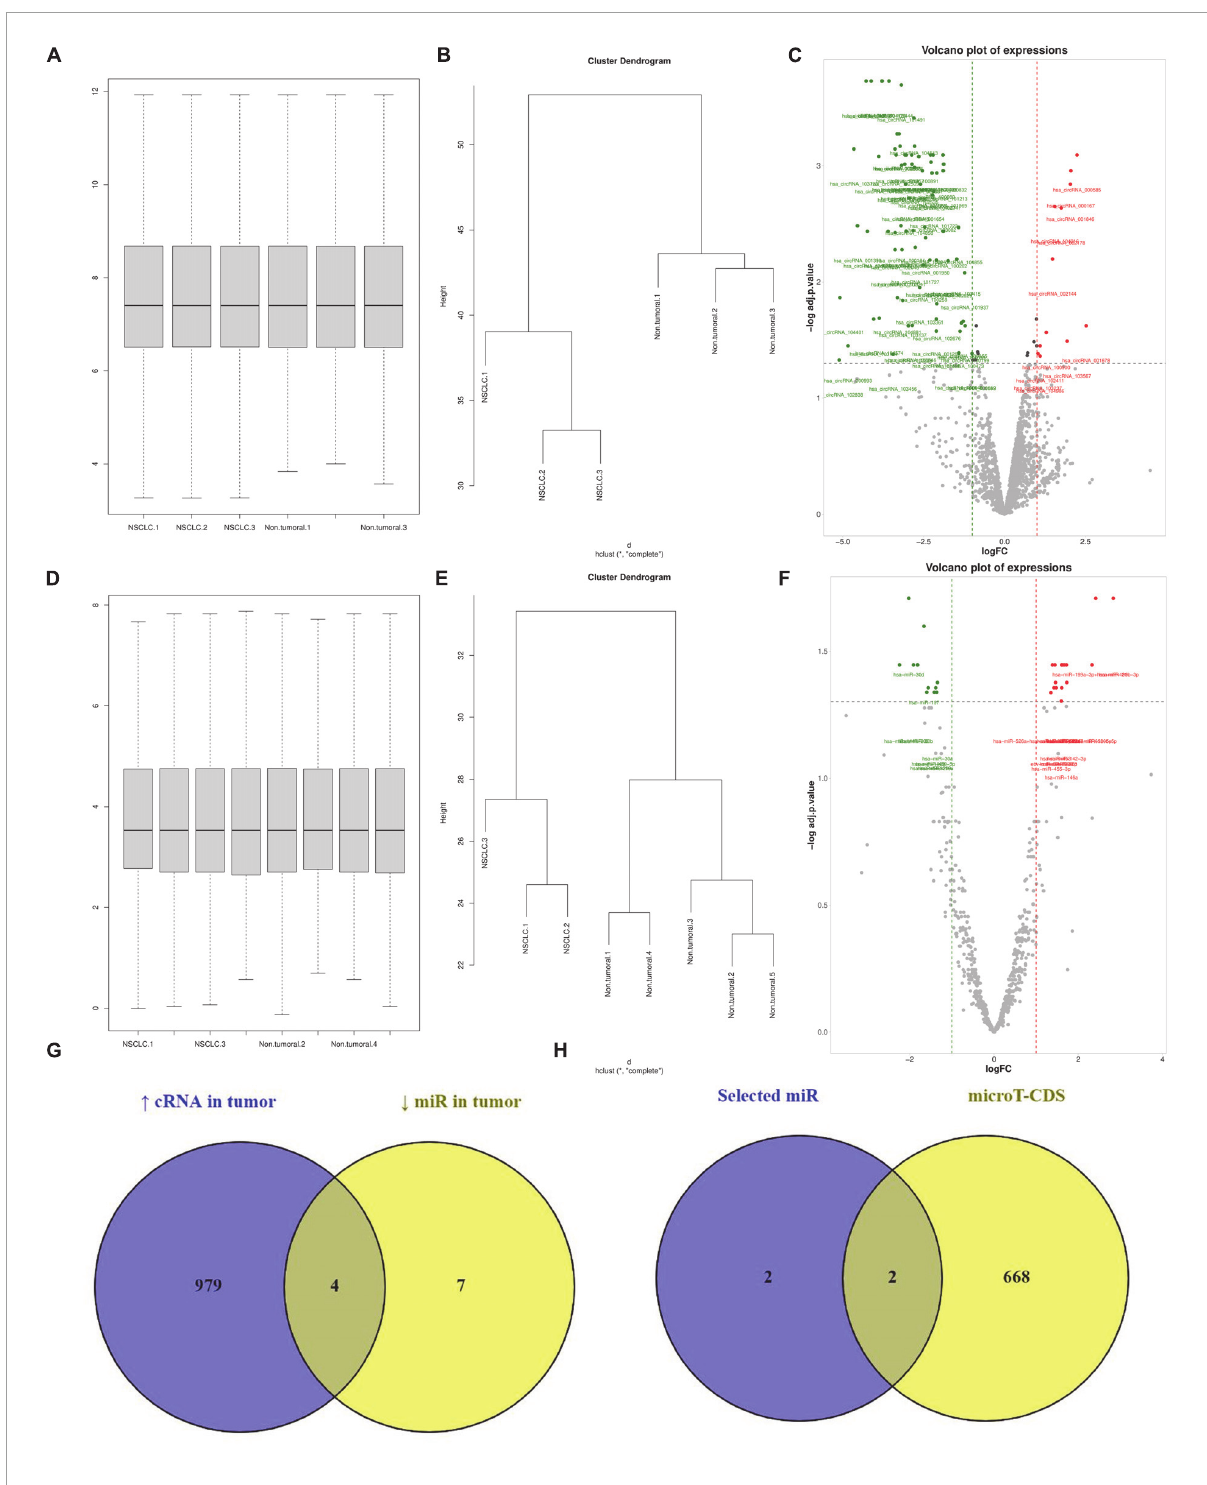
FIGURE4 has_circ_0002476/hsa-miR-216a-5p/PD-L1 and hsa_circ_0063526/hsa-miR-1299/PD-L1 might increase programmed death-ligand 1 (PD-L1) expression in non-small cell lung cancer (NSCLC). (A–C) Normalizing, clustering, and identifying differentially expressed circRNAs from the GSE158695 dataset. (D–F) Normalizing, clustering, and identifying differentially expressed circRNAs from the GSE63805 dataset. (G) Identifying the commonality between the miR targets of upregulated circRNAs in NSCLC tissues between the downregulated miRs in NSCLC tissues. (H) Identifying which of those miRs can target PD-L1 based on the microT-CDS